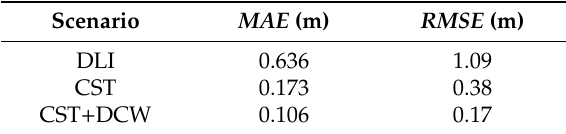
Table 2. Errors of the predicted riverbed elevation for the Baxter River reach.